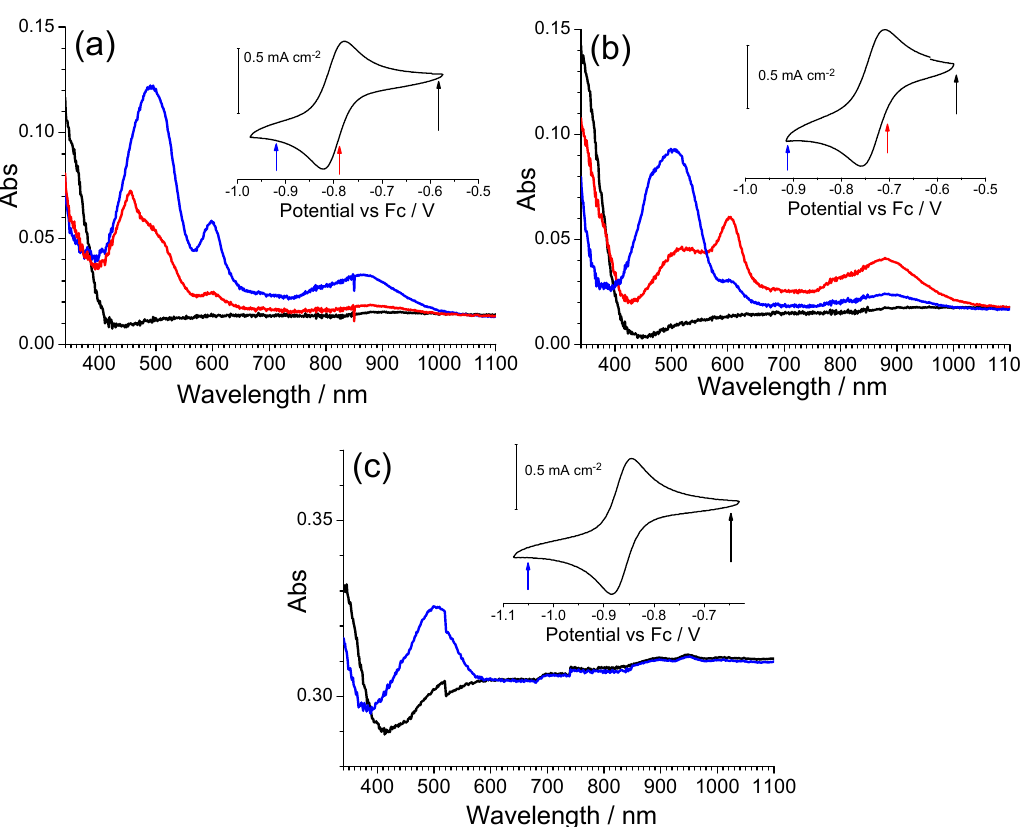
Figure 7. Spectroelectrochemistry of derivatives ( a ) FiQ-Q (F-substituent on the isoquinolinic ring), ( b ) iQ-ClQ (Cl on the quinolinic ring), and ( c ) twQ-iQ (buthylene chain).